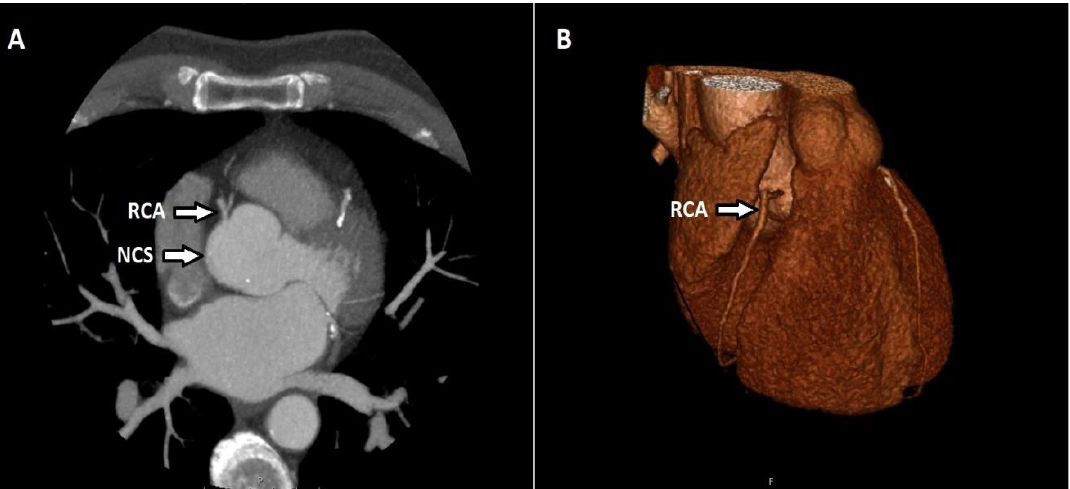
Figure 2. Axial CT maximum-intensity projection (MIP) ( A ) and volume-rendered (VR) ( B ) image shows the RCA originating in the noncoronary sinus (NCS).